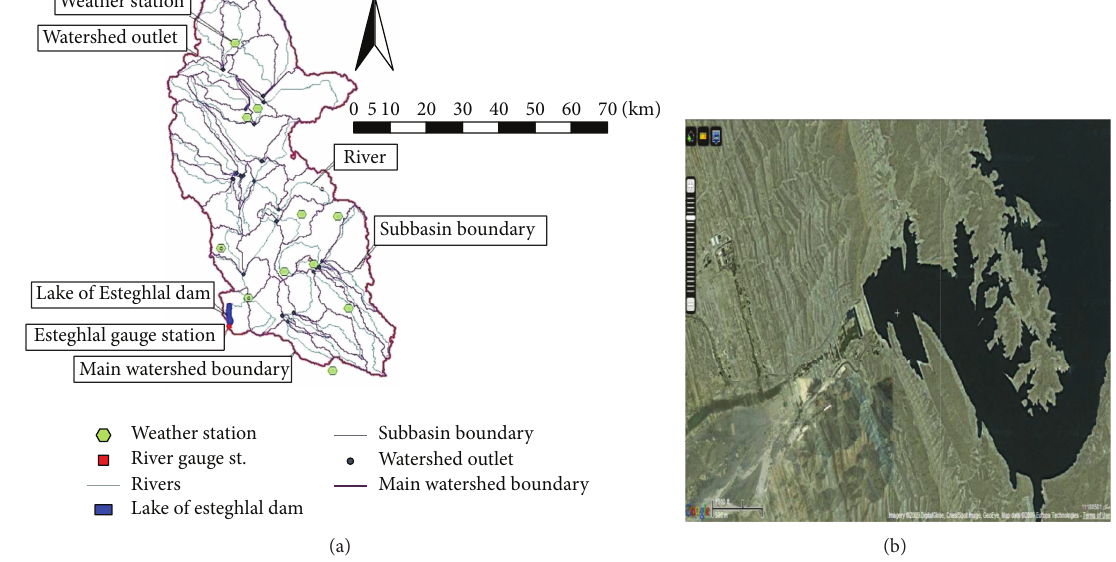
Figure 2: Roodan watershed in south of Iran (a); satellite image for the reservoir of Esteghlal (Minab) dam (b).